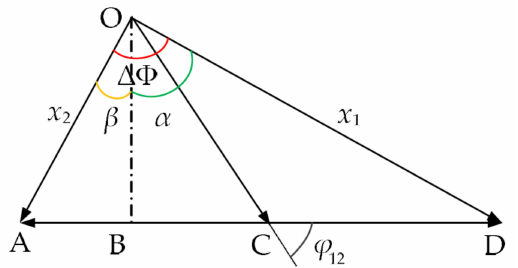
Figure 3. The vector synthesis of the two-order modal response (OB is perpendicular to AD, ∆Φ = α + β